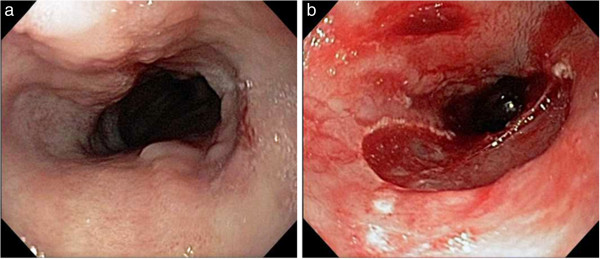
Endoscopic images demonstrating the area of BE with nodularity before (a) and after (b) resection.